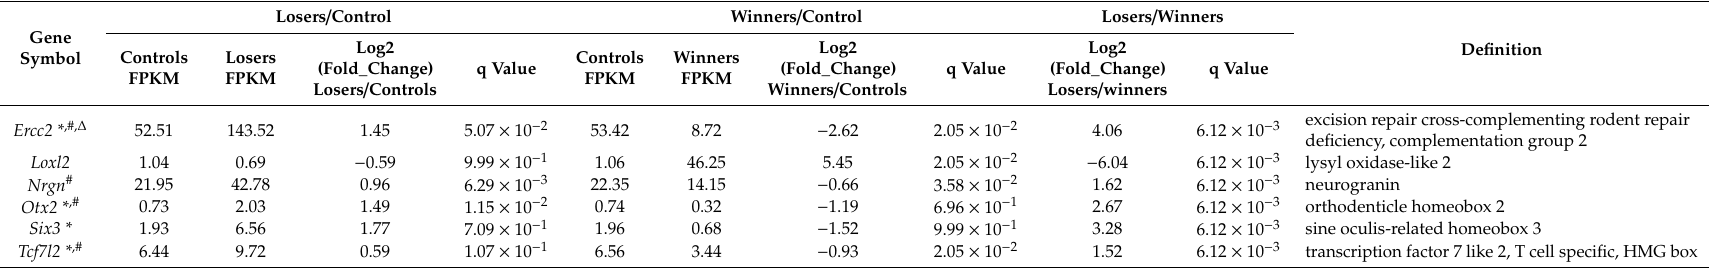
Table 6. Expression of genes that changed the level of transcription in comparisons of Losers vs. Control and Winners vs. Control in di ff erent directions and characterized as DEGs when comparing Losers vs. Winners.